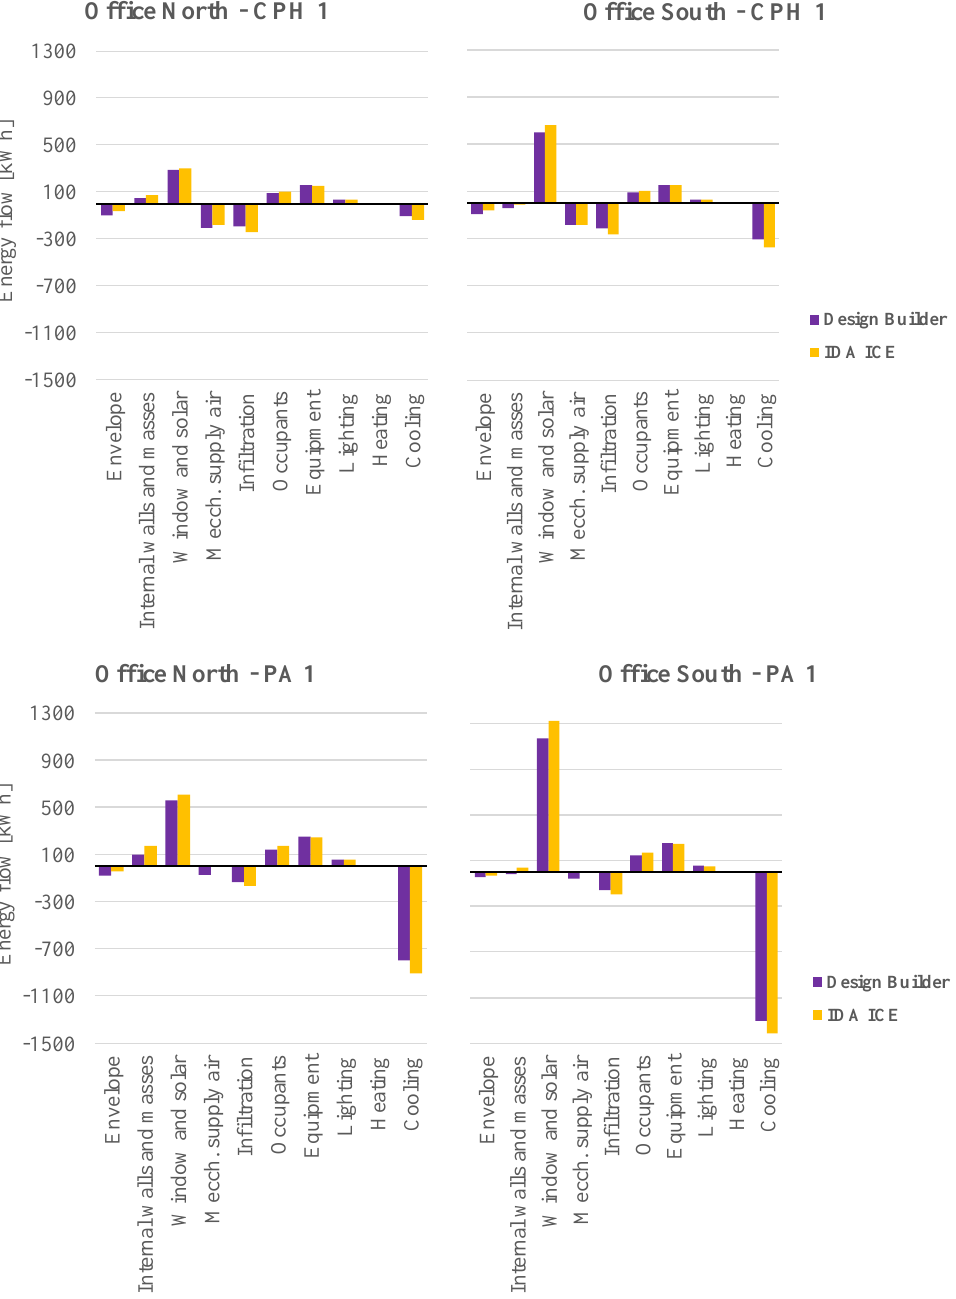
Figure 8. Energy flows for Copenhagen (up) and Palermo (down) in scenario 1 during the cooling season.